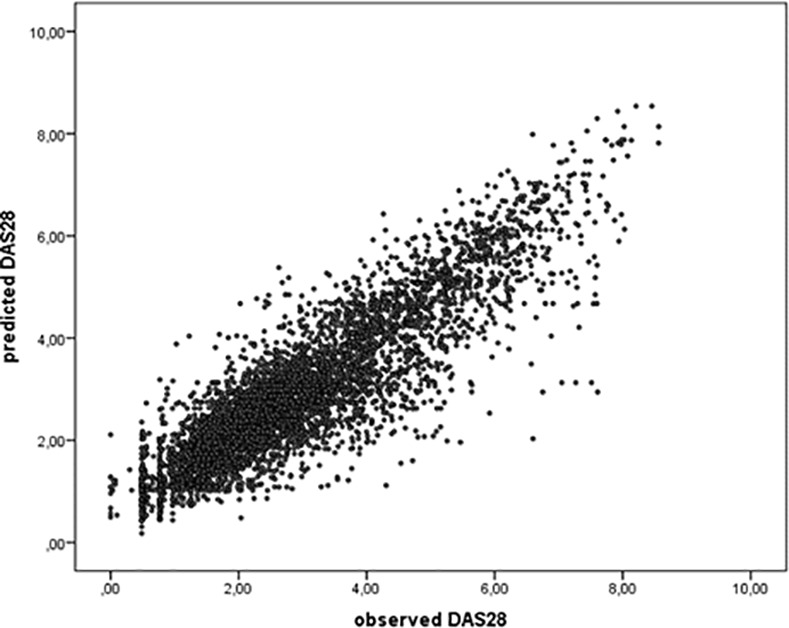
Fit of the predicted DAS28 to the observed DAS28.